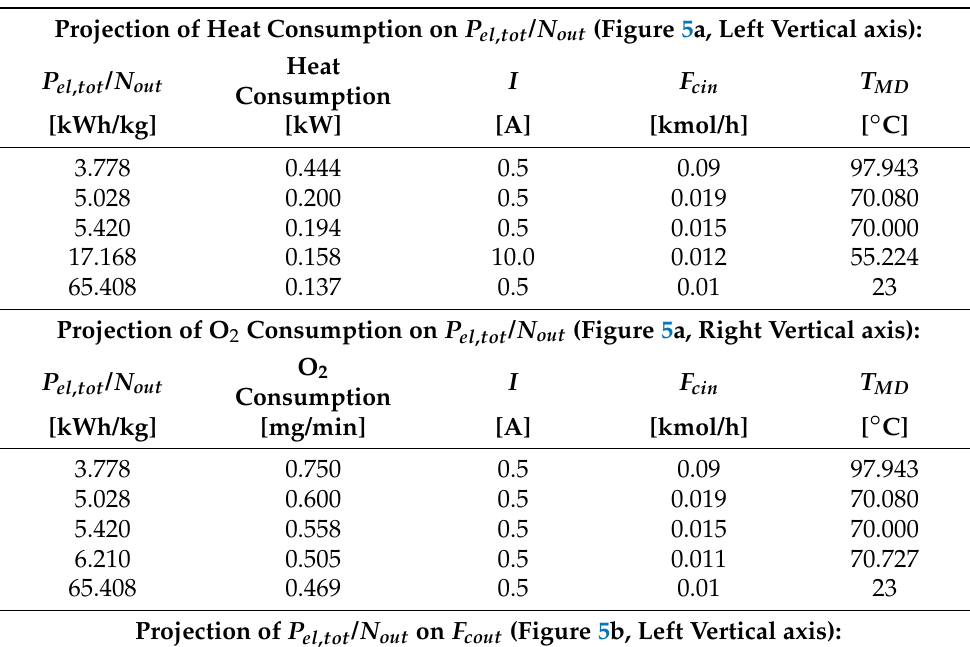
Figure 5. Two-dimensional projections of the Pareto approximation. The different objectives on the vertical axes are displayed in relation to ( a ) P el , tot / N out and ( b ) F cout on the respective horizontal axes. In each sub-figure, the black dots belong to the left vertical axis and the O 2 consumption marked by red squares is allocated to the right vertical axis, as exemplarily indicated by the arrows in ( a ). Table 5. Objectives and optimization variables selected from the Pareto set resulting from MCO for the process. Only non-dominated points, plotted in Figure 5, are given